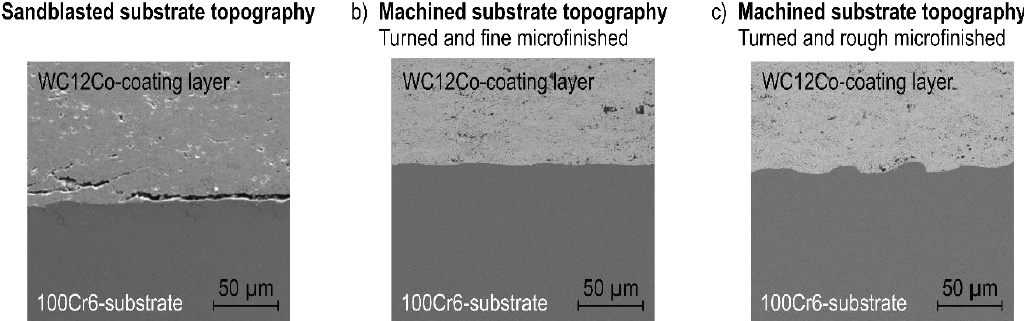
Figure 13. Cross section SEM picture on the coating interface for ( a ) sandblasted, ( b ) turned and fine microfinished, and ( c ) turned and rough microfinished substrate. microfinished, and ( c ) turned and rough microfinished substrate.